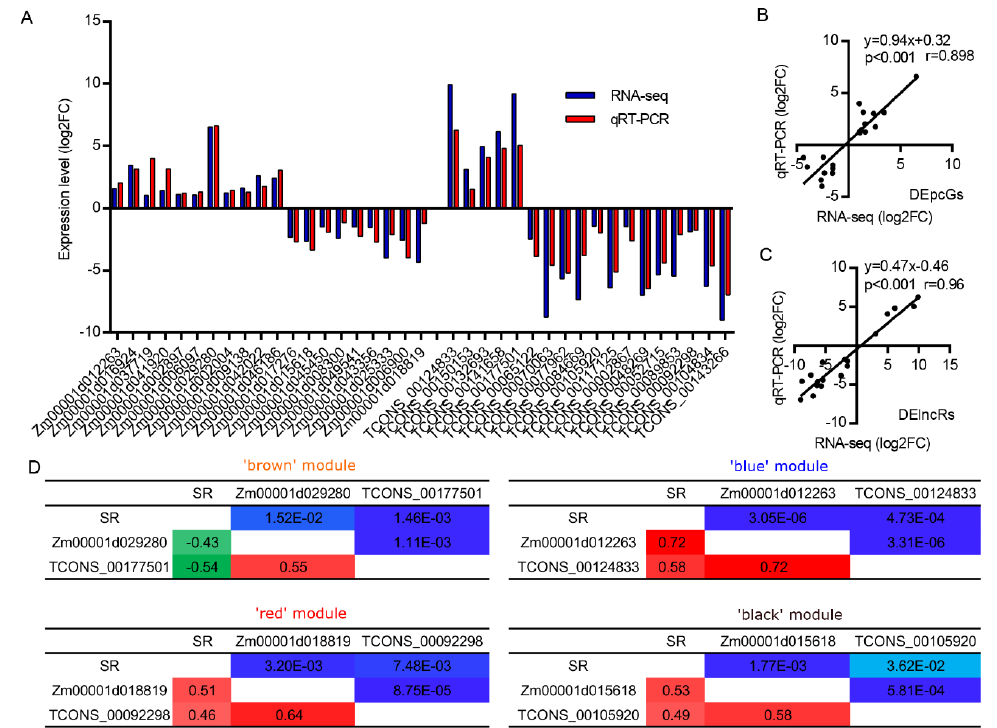
Figure 5. The expression levels of protein-coding genes (PCgenes) and long non-coding genes (lncRNAs) in maize seedlings after 4 h waterlogging stress (WS). ( A ) qRT-PCR verification of the expression of 20 differentially expressed PCgenes (DEpcGs) and 18 differentially expressed lncRNAs (DElncRs) in B73 seedlings after a 4 h WS condition. ( B ) The expression correlation between the qRT-PCR and RNA-seq of the 20 DEpcGs in B73 seedlings after a 4 h WS condition. ( C ) The expression correlation between qRT-PCR and RNA-seq of the 18 DElncRs in B73 seedlings after a 4 h WS condition. ( D ) The expression correlation of DEpcG and DElncR in the ‘brown’, ‘blue’, ‘red’, and ‘black’ modules among the 32 different maize genotypes after a 4 h WS condition are shown. The lower triangle indicates the correlation coefficient, and the upper triangle indicates the p-value of the correlation. The relative expressions of each DEpcG and DElncR in each genotype were calculated based on the control samples (not stress), which were further transformed through the function log 2 (). FC, foldchange; SR, survival rate of 32 maize genotypes, which were taken from Yu et al. (2019) [48].